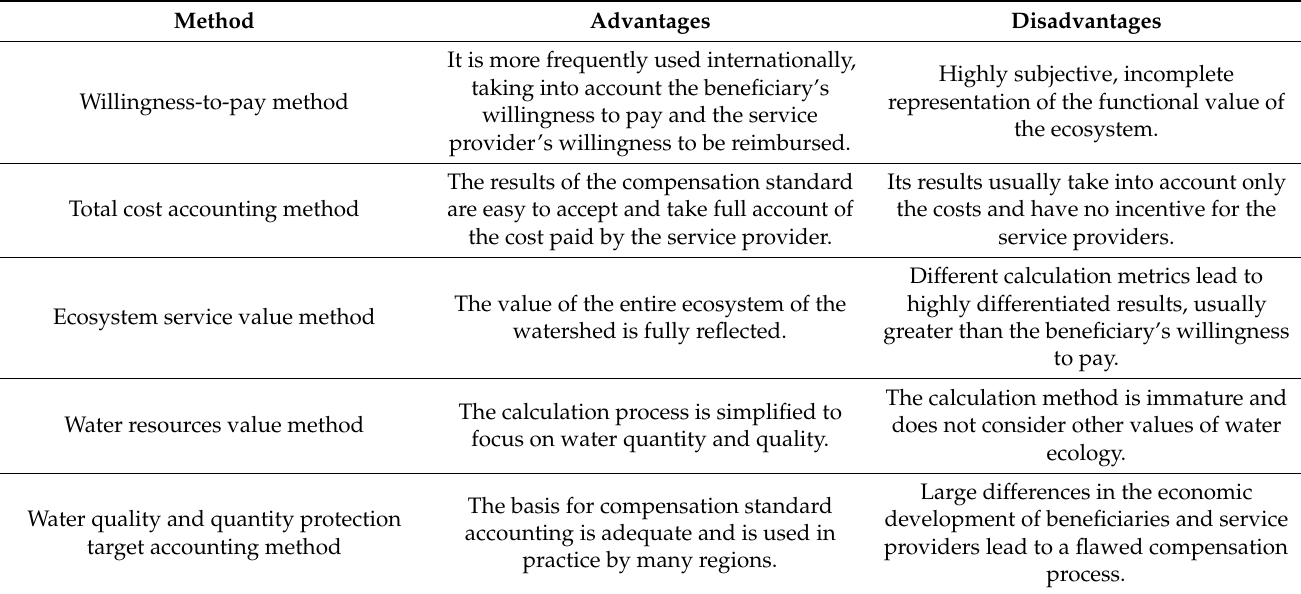
Table 1. Advantages and disadvantages of different watershed ecological compensation standard accounting